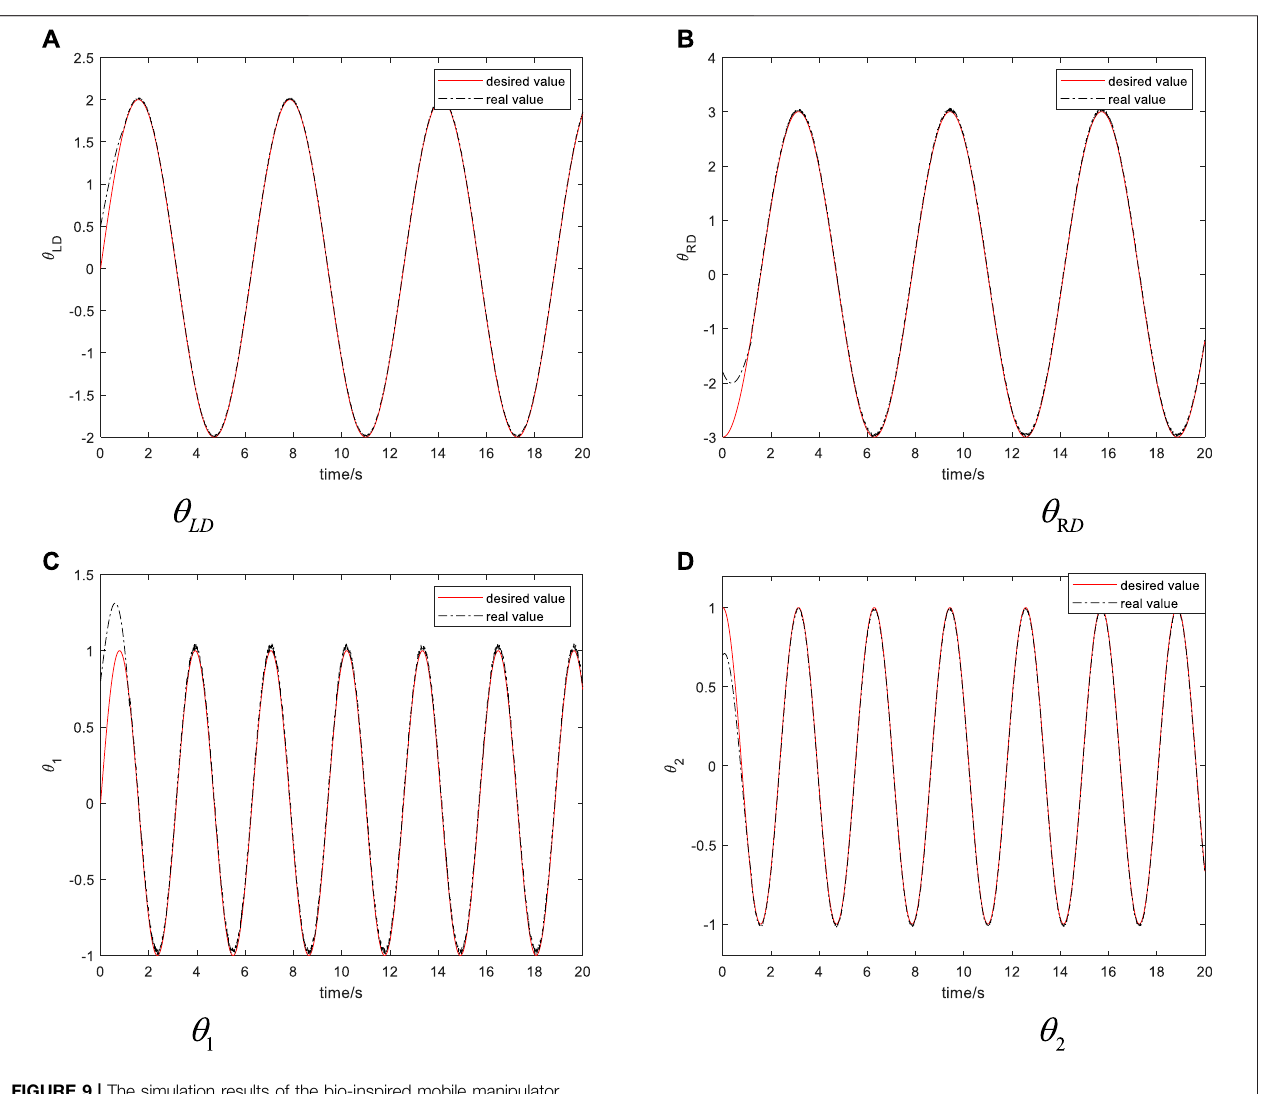
FIGURE 9 | The simulation results of the bio-inspired mobile